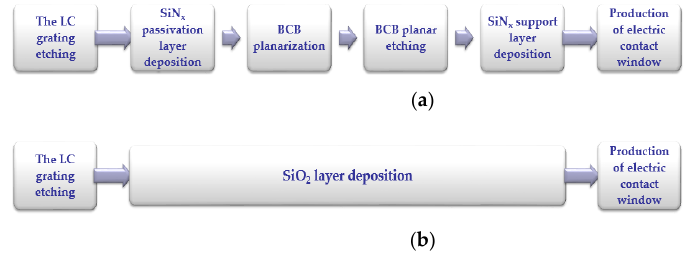
Figure 3. The comparison diagram of ( a ) BCB planarization process and ( b ) SiO 2 planarization process